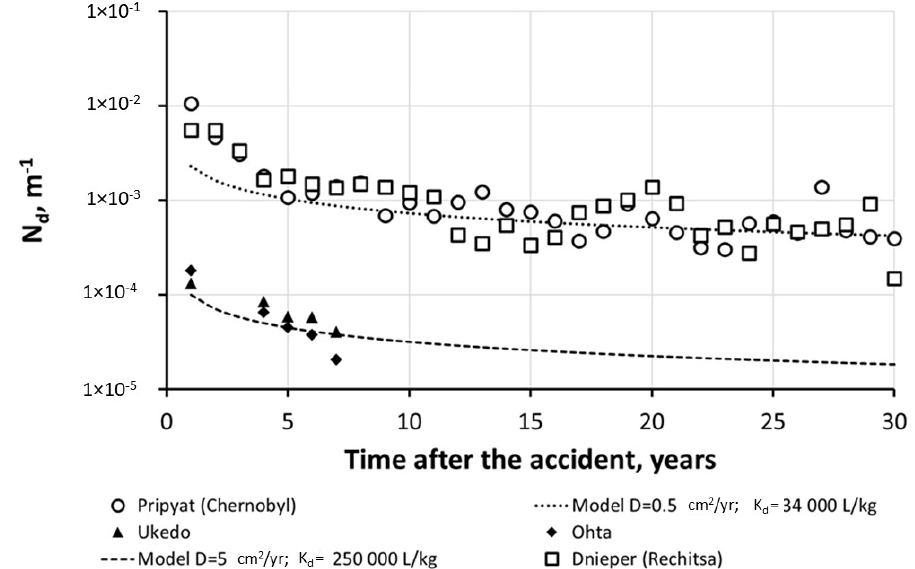
Figure 8. Comparison of mean annual dissolved 137 Cs wash-off ratios N d from catchments of Ukedo and Ohta Rivers in Fukushima area (based on data from [97,98]) with those for Pripyat River at Chernobyl and Dnieper River at Rechitsa in Chernobyl area (based on data from [102]) and with estimation by semiempirical diffusional model [18,79,144]. Reprinted/adapted with permission from Ref. [79]. Copyright year 2022, copyright owner’s name SPRINGER Nature.